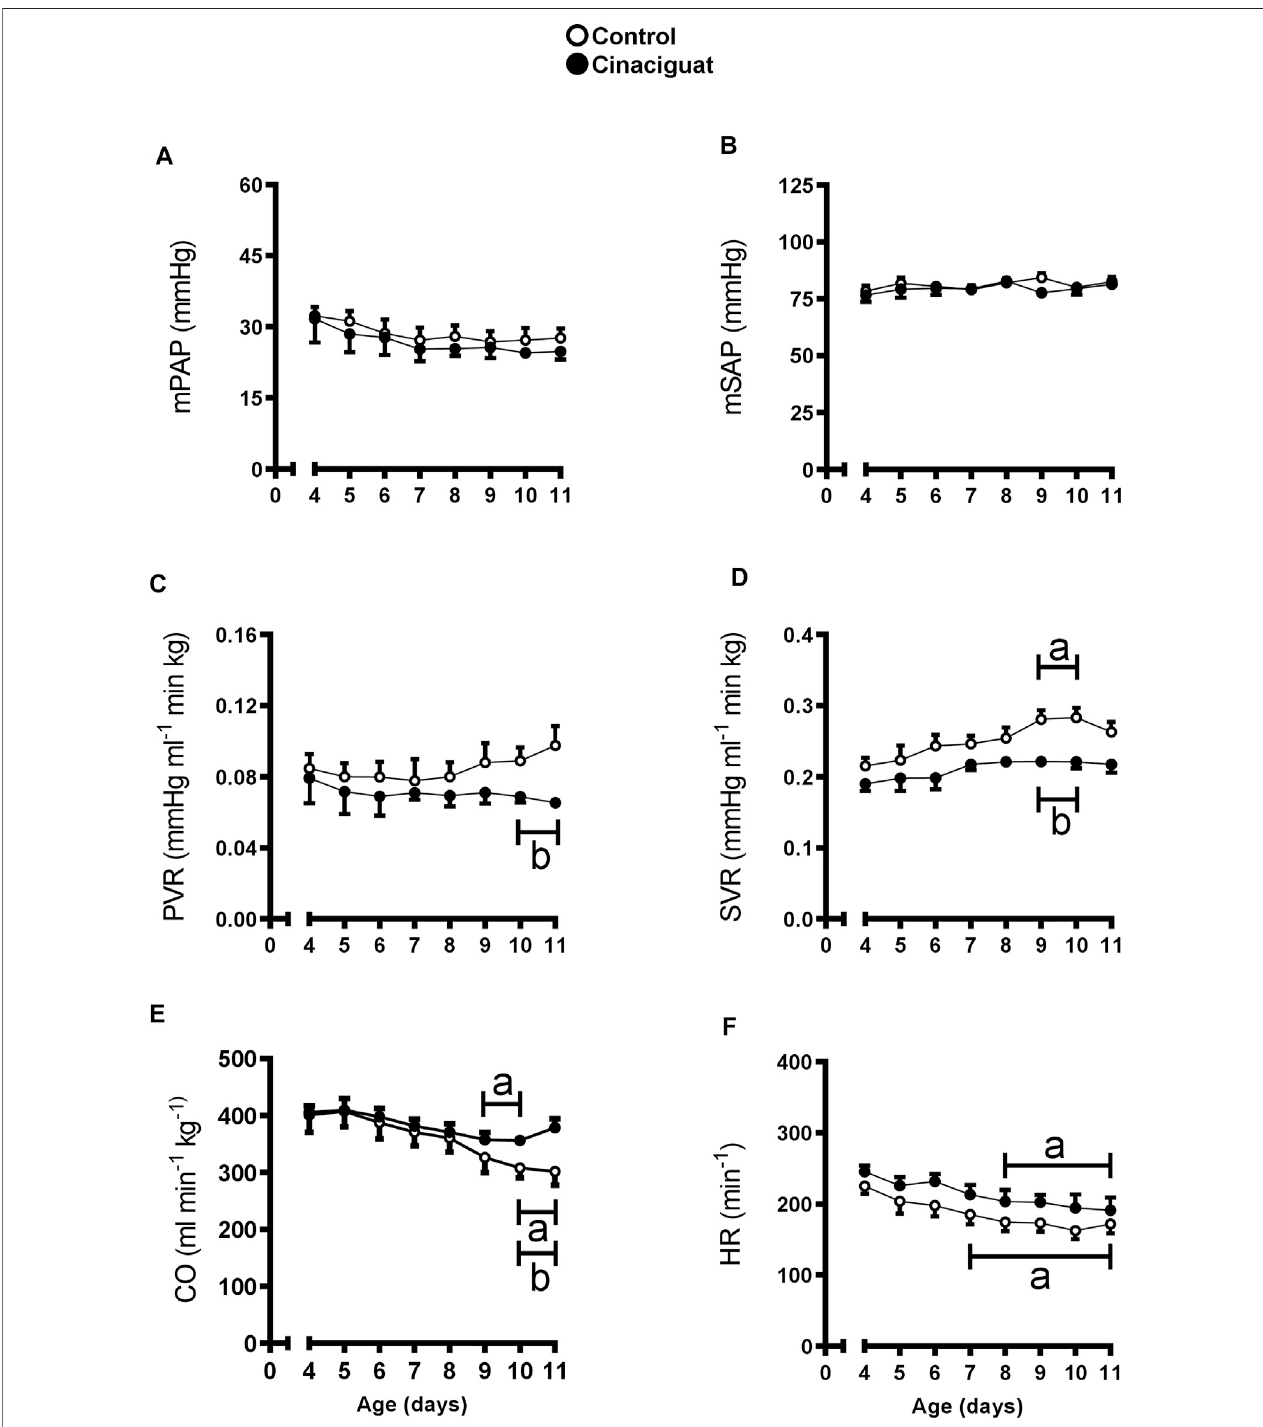
FIGURE 2 | Time-course of basal cardiopulmonary and systemic circulation variables in chronically hypoxic and pulmonary hypertensive neonatal lambs treated with a daily bolus of Cinaciguat. Mean pulmonary arterial pressure [mPAP, (A) ]; mean systemic arterial pressure [mSAP, (B) ]; pulmonary vascular resistance [PVR, (C) ]; systemicvascularresistance[SVR, (D) ];cardiacoutput[CO, (E) ],andheartrate[HR, (F) ].Control(Opencircles, n =6)andCinaciguat-treatedlambs(Blackcircles, n =6). Values are means ± SEM. Signi fi cant differences ( p ≤ 0.05): a vs. basal period, b vs. Control group.